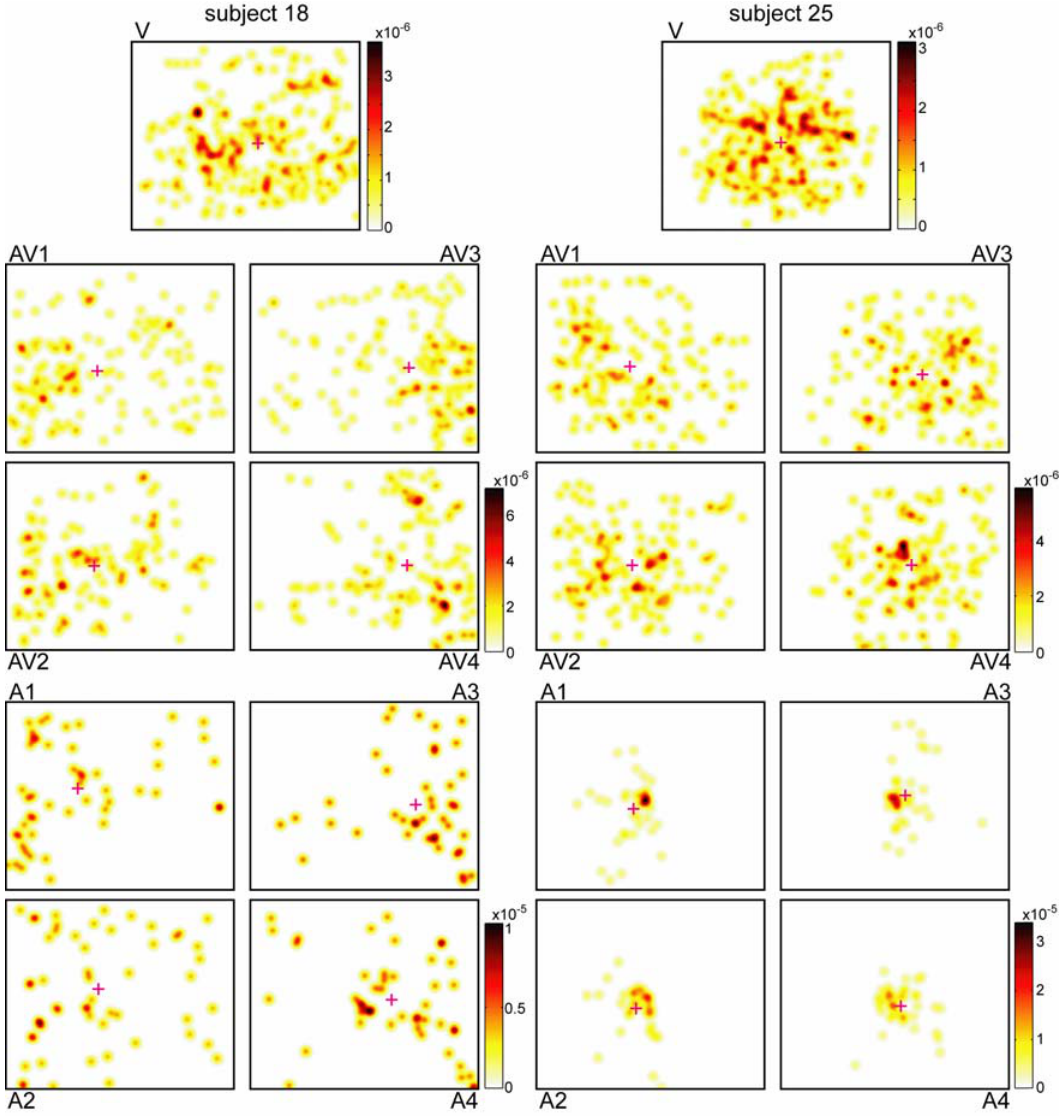
Figure 4. Data from two representative subjects. Pdfs constructed from eye movements of separate subjects are shown for each experimental condition: unimodal visual (V), unimodal auditory (A1-4), and multimodal audiovisual (AV1-4). Each pdf includes fixations made by the subject when presented with all stimuli of the corresponding condition. Probability of fixation is denoted by increasing colour; see colour bars provided with each condition and subject for corresponding scale. Centre of gravity is indicated on each pdf by a